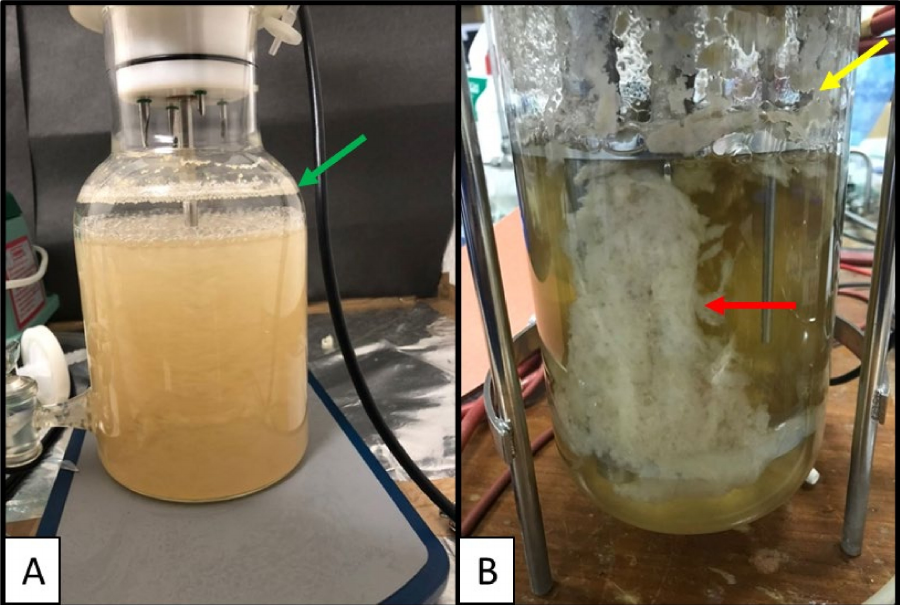
Figure 6. Differences in mycelium culture between ALSB ( A ) and commercially used STR-Bioreactor ( B ) for comparison study using the verified optimised